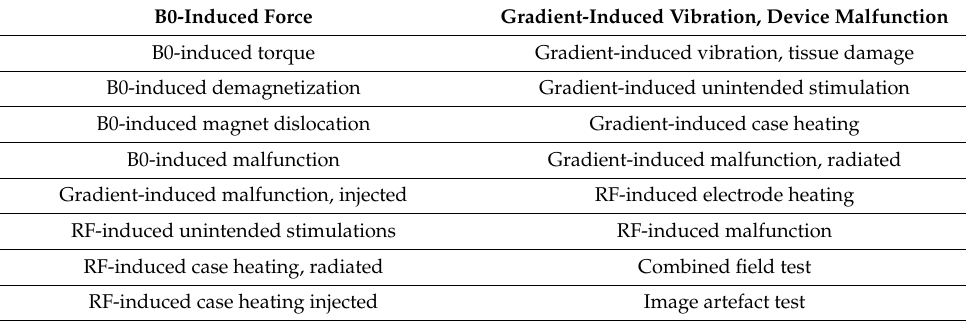
Table 2. Legend Table 2: ISO 10974 testing for assessment of MRI safety of active implantable medical devices. B0—static effect; RF—radio frequency-induced effects; and gradient-induced effects generated by the change in magnitude and direction of the magnetic